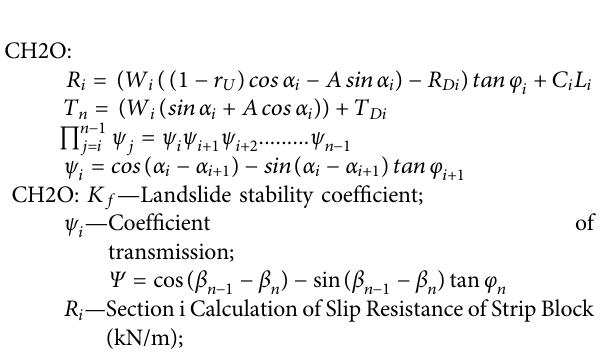
FIGURE 4 | Cumulative deep displacement duration curve of B-B section.